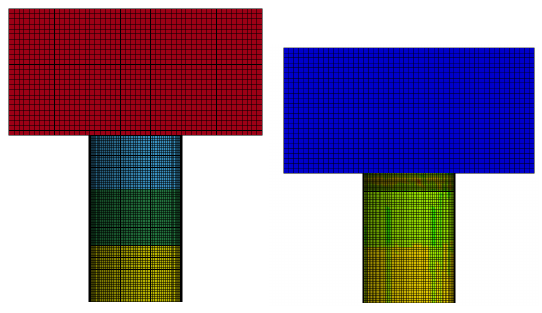
Figure 9. Simulation experiment of series combined impact of honeycomb structure.